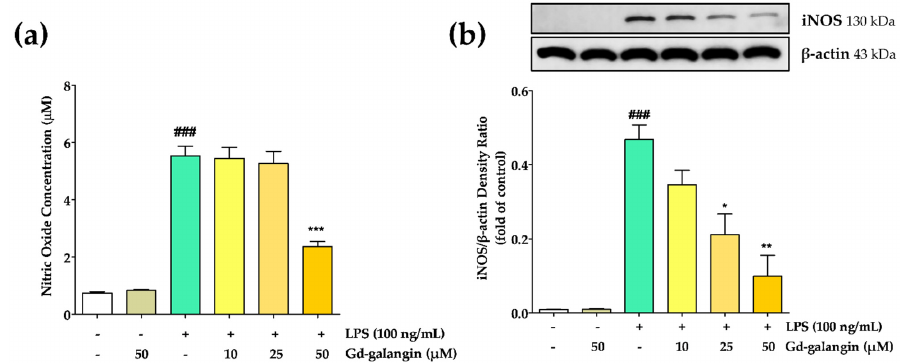
Figure 6. Effects of Gd-galangin on lipopolysaccharide (LPS)-stimulated ( a ) nitric oxide (NO) and ( b ) inducible nitric oxide synthase (iNOS) expression. (Data are shown as the mean ± SEM, t -test, n ≥ 3. ### p < 0.001 compared to control group; * p < 0.05, ** p < 0.01, *** p < 0.001 compared to LPS- stimulated group.).